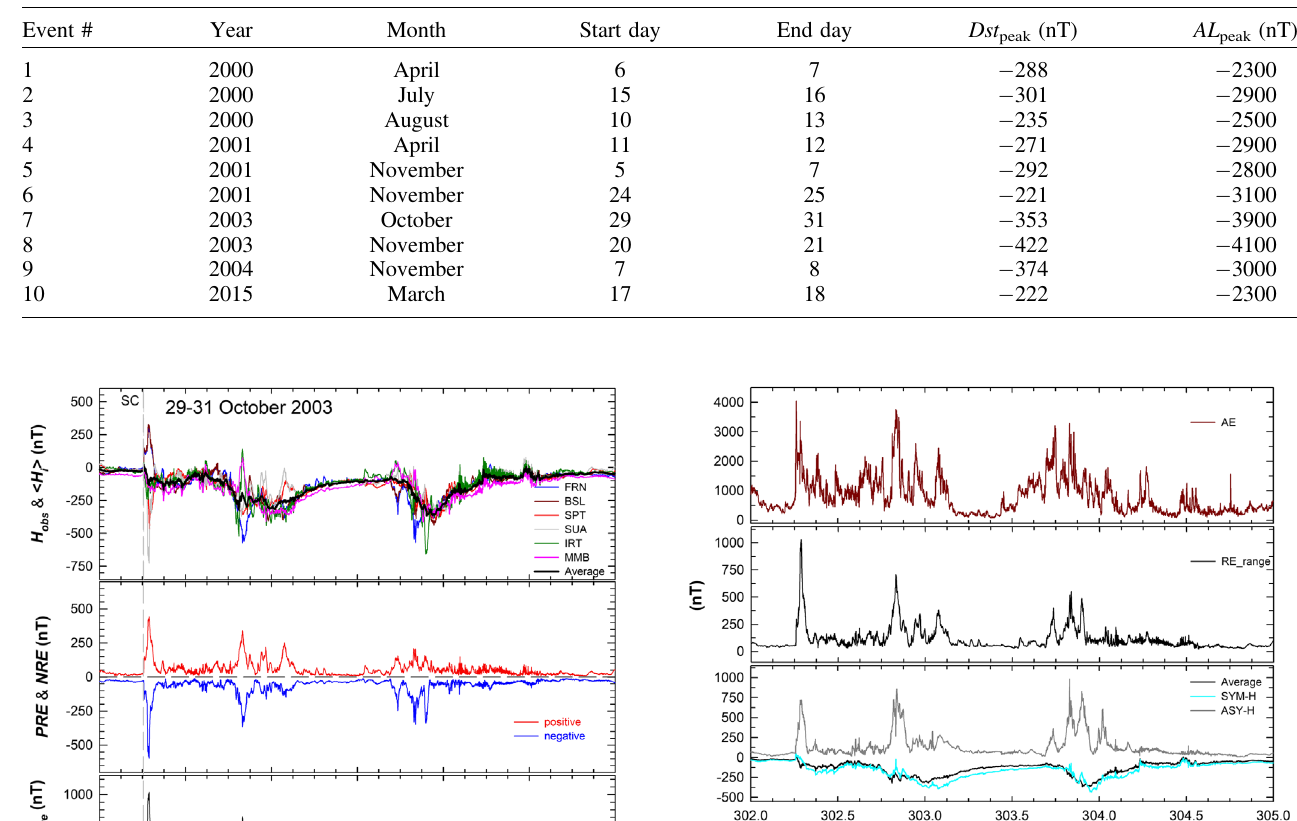
Table 3. List of extreme events at mid-latitude according to the following criteria: Dst (cid:1) (cid:3) 200 nT and AL (cid:1) (cid:3) 2000 nT. Availability of local magnetic fi eld data from all six observatories in Table 1 is also mandatory.